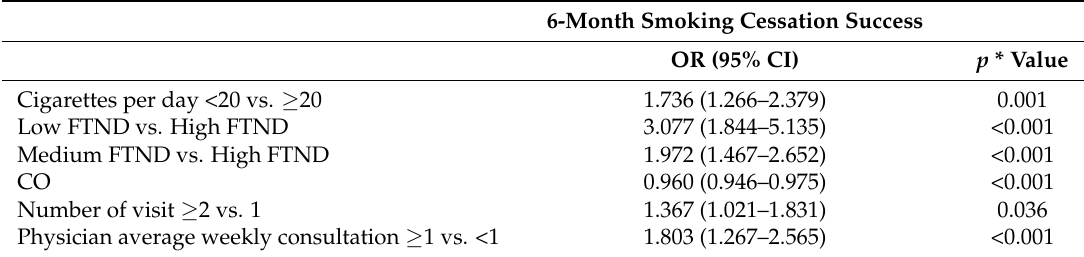
Table 2. Factors associated with six-month smoking cessation success ( N =